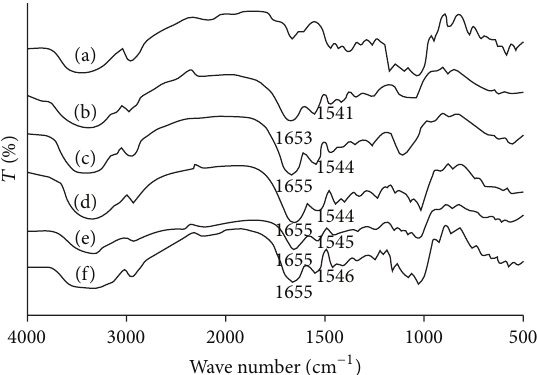
Figure 4: FTIR spectra of (a) starch and (b) gelatin and drug- loaded blend microparticles with starch/gelatin blend ratios of (c) 0/100, (d) 20/80, (e) 35/65, and (f) 50/50 (w/w) crosslinked with 25 g glutaraldehyde/100 g starch/gelatin.